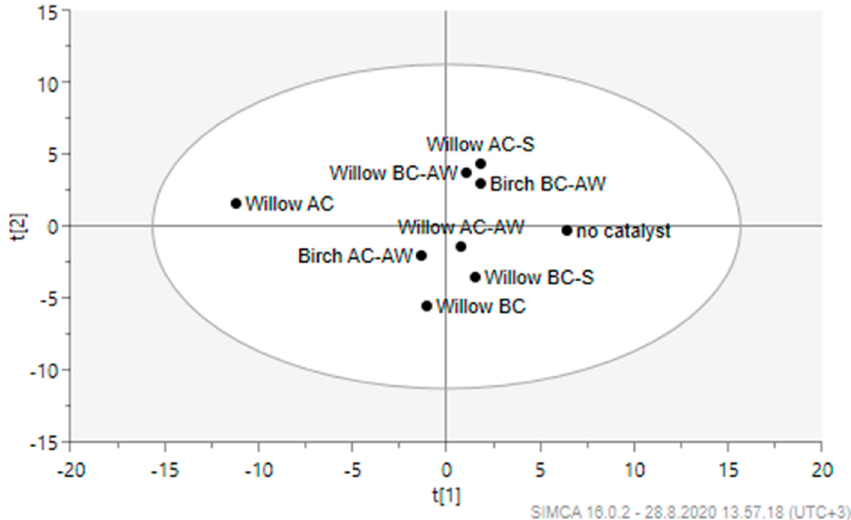
Figure 3. Principal component analysis (PCA) of the pyrolysis data for catalyst and no catalyst treatments (Table A1). The score plot of the two principle components shows how the samples are related to each other. BC = biochar, AW = acid washed, S = sulfonated, AC = activated carbon.